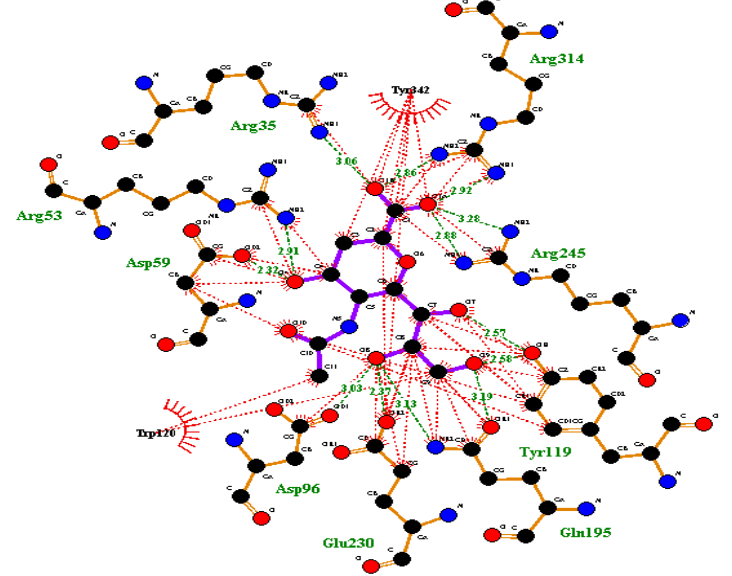
Figure 1. Sialic acid analogous 2,3-dehydro-3-deoxy- N -acetylneuraminic acid (DANA) interaction on active sites of Trypanosoma cruzi trans -sialidase (TcTS) enzyme (green line showing a conventional hydrogen bonding interaction and red lines showing a hydrophobic interaction). The image was produced with LigPlot+ software (v.1.4, European Bioinformatics Institute (EMBL-EBI), Hinxton, Cambridge, UK).